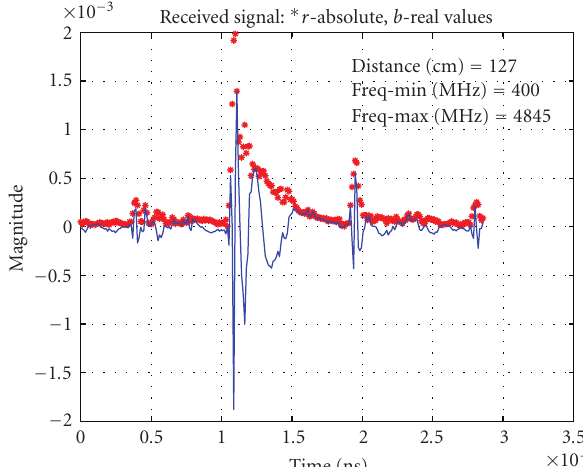
Figure 1: The received signals, in time domain, for 4445 MHz frequency span (128 frequencies).